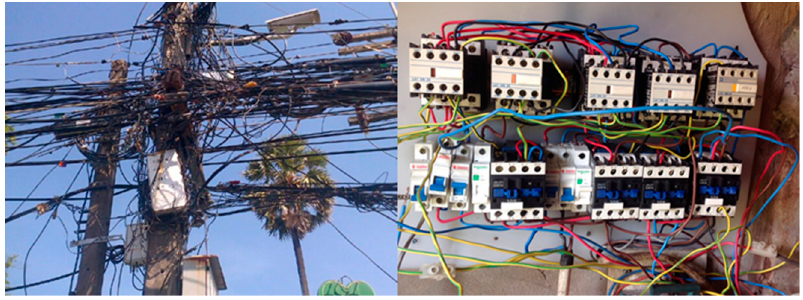
Figure 1. Illegal connections and Inadequate Setup.